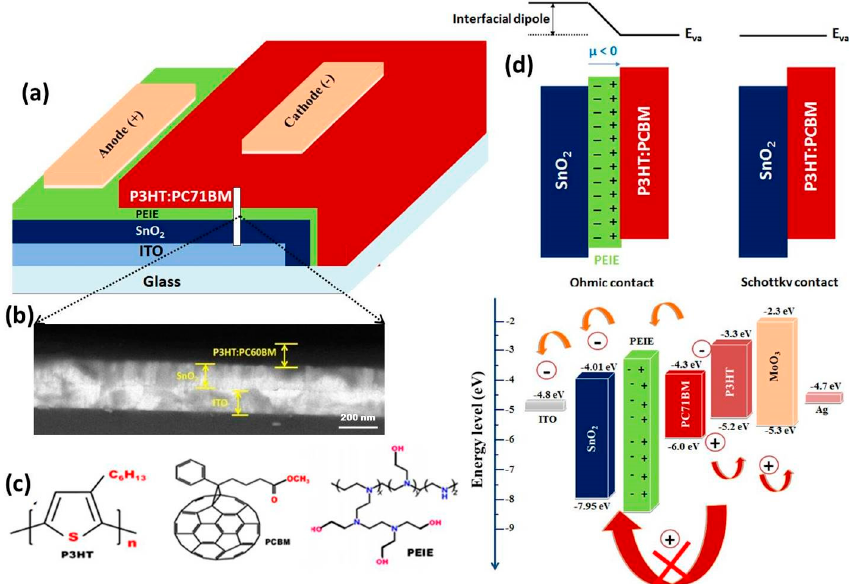
Figure 1. ( a ) Schematic structure of the inverted hybrid solar cell. ( b ) Cross-sectional SEM figure of device used in this study. ( c ) Chemical structure of P3HT, PCBM and PEIE. ( d ) Energy level diagram of the inverted hybrid solar cells investigated in this work.